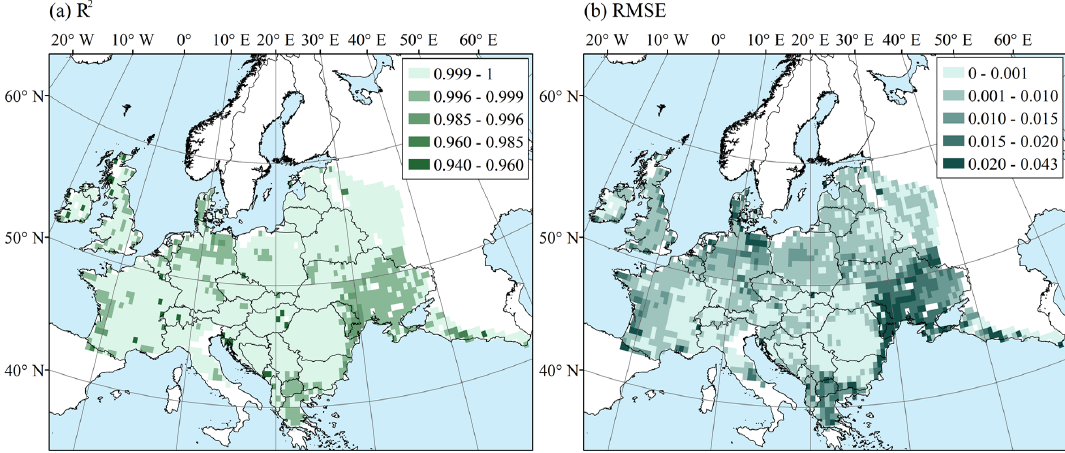
Figure 4. Goodness of fit of grid vulnerability curves, including R 2 and RMSE measures.